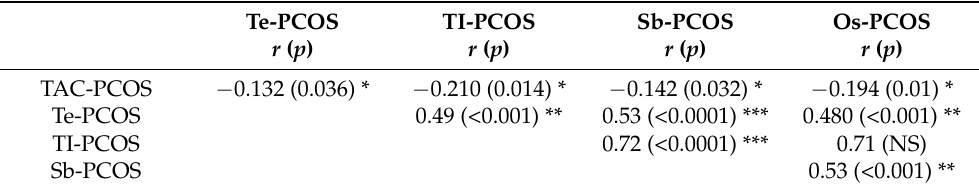
Table 2. Correlation coefficients values Te, TI, Os, Sb and TAC in PCOS